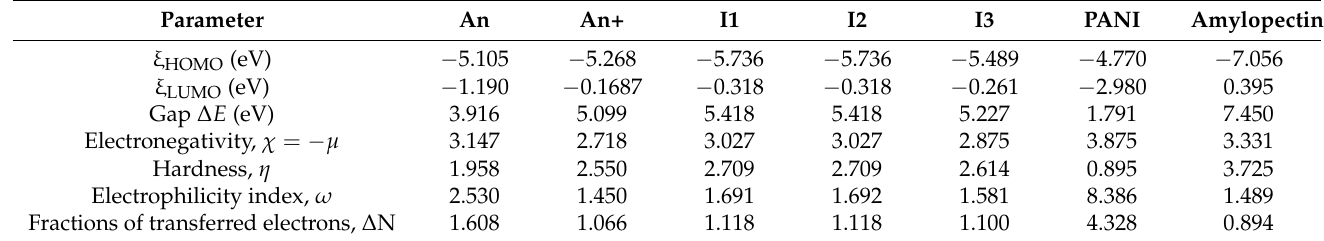
Table 9. ξ HOMO , ξ LUMO and related molecular properties of the studied compounds.